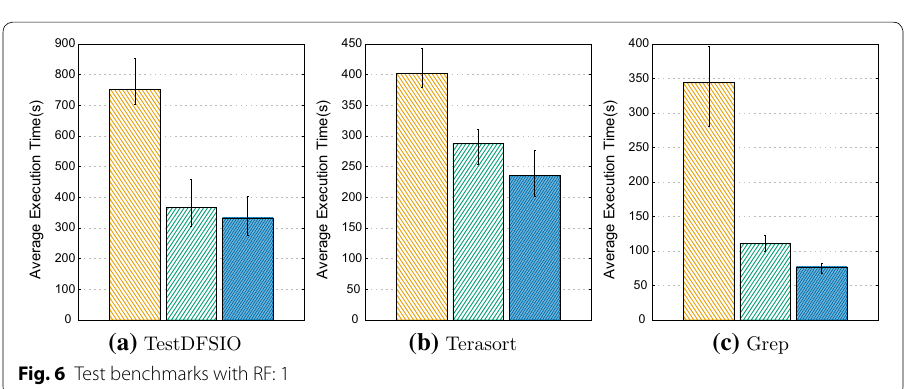
Fig. 6 Test benchmarks with RF: